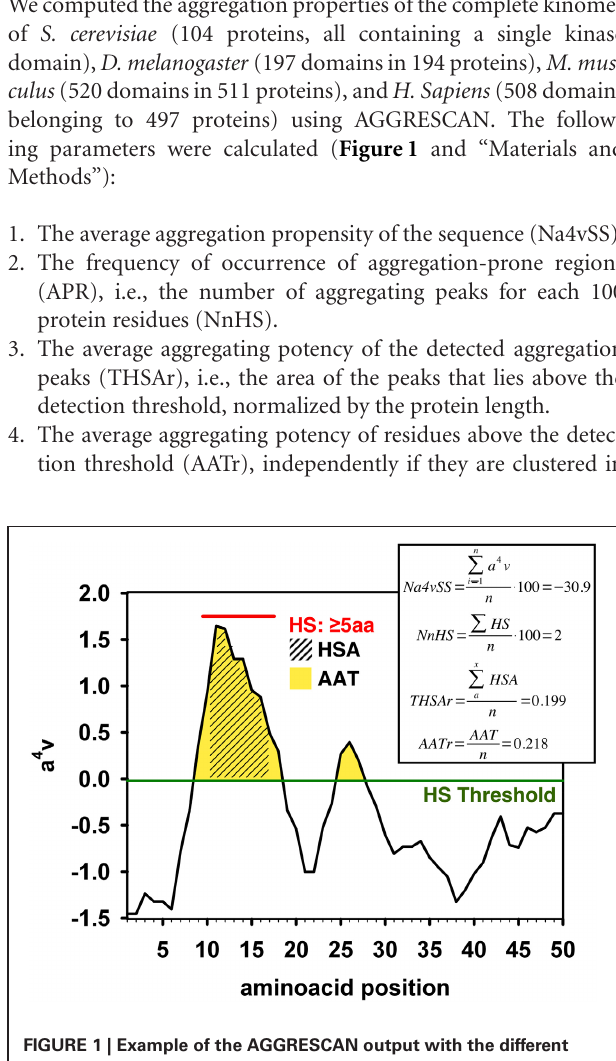
FIGURE 1 | Example of the AGGRESCAN output with the different parameters calculated by this algorithm. The aggregation profile is represented as the value of the experimentally derived parameter a 4 v (de Groot et al., 2005) plotted against the query sequence. An overall value of this parameter is given for the whole sequence by dividing the a4v sum for all positions over the number of amino acids an multiplying by 100 (Na4vSS). An aggregation-prone region (APR) or Hot-Spot (HS) is detected whenever a stretch of 5 or more consecutive amino acids, none of them being a proline, with a4v values above the HS Threshold (HST) is found. The normalized number of Hot Spots (NnHS) is calculated as the number of Hot-Spots detected divided by the sequence length and multiplied by 100. The area of the profile above the threshold gives an idea of the aggregation potential of the sequence or a certain region; it can be calculated for the whole profile (AAT) or limiting it to the detected Hot-Spots (HSA). The area values are normalized dividing by the number of amino acids in the input sequence.